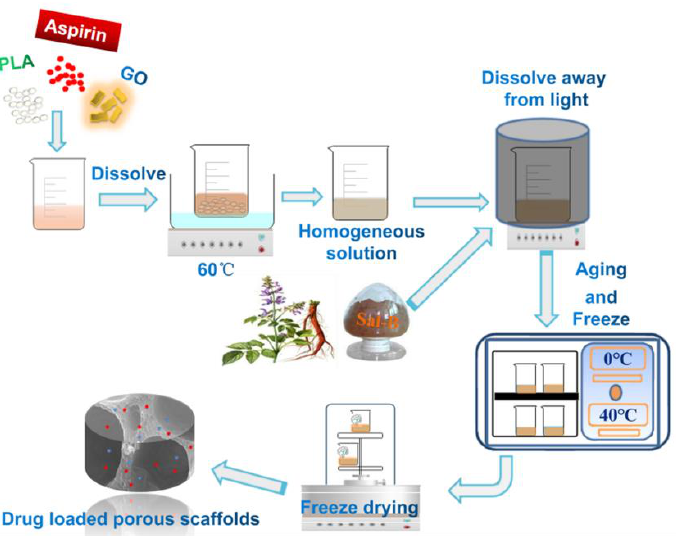
Figure 1. The flow chart of fabrication of dual drug-loaded biomimetic composite scaffolds.